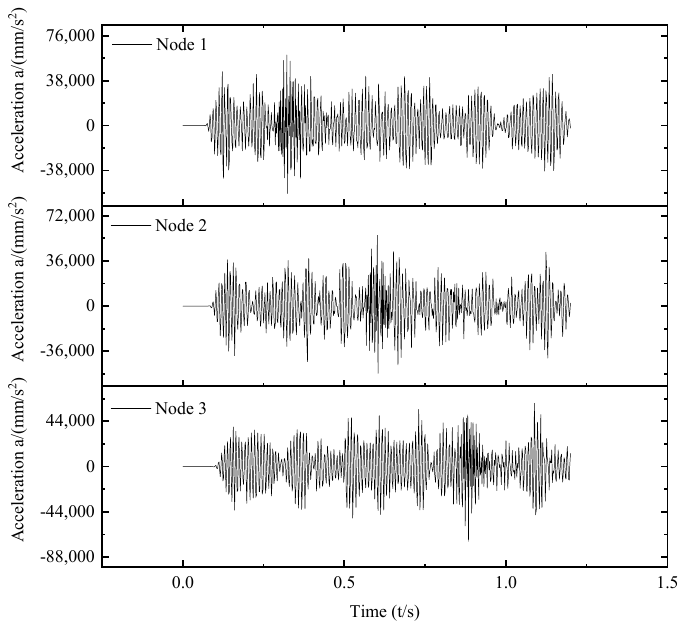
Figure 12. Node acceleration time-history curve. As shown in Figures 11 and 12, from the velocity and acceleration curves, it can be seen that when the load passed over the node, the vibration frequency changed greatly, and the velocity and acceleration fluctuation also increased to a certain extent. The selected coil sizes were height h = 10 mm, inner diameter r 1 = 10 mm, outer diameter r 2 = 12 mm and wire diameter d = 0.22 mm, and the permanent magnet sizes were height h M = 10 mm and radius r 0 = 9 mm. The relationship between the calculated electromechanical coupling coefficient k u and z c is shown in Figure 13.